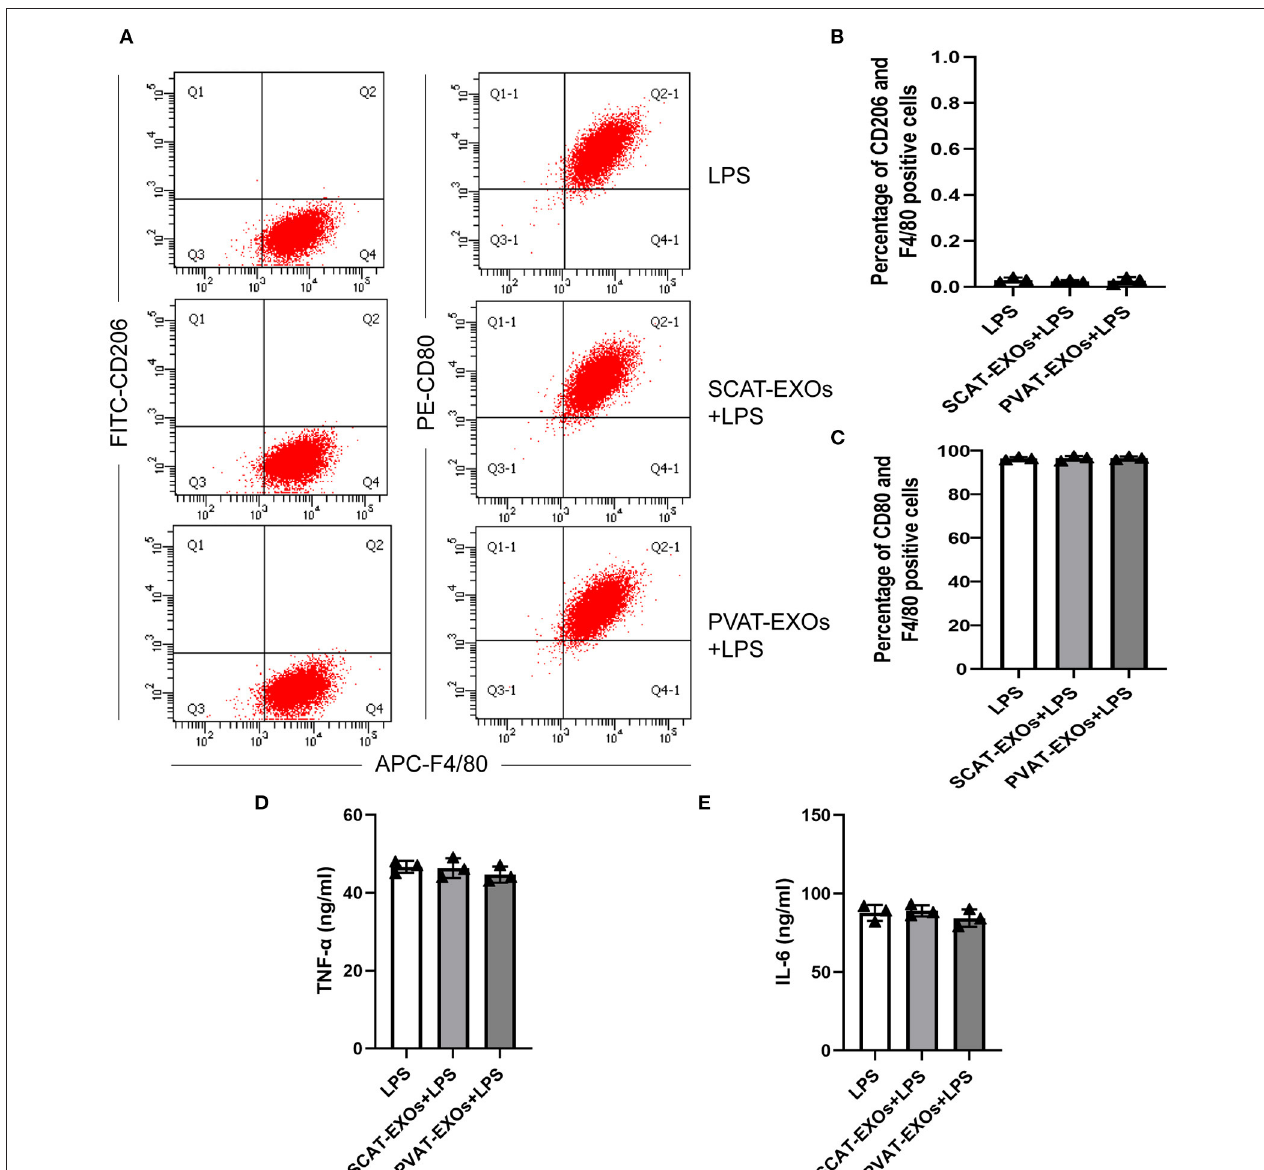
FIGURE 4 | Macrophage polarisation was not affected by SCAT-EXOs or PVAT-EXOs. RAW264.7 cells were incubated with SCAT-EXOs, PVAT-EXOs or equal amounts of PBS and then incubated with lipopolysaccharide (LPS). The phenotypes of cells were analysed by flow cytometry (A) . There was no significant difference in the percentages of CD206 + /F4/80 + cells or CD80 + /F4/80 + cells between the groups (B,C) . The production of TNF-a (D) or IL-6 (E) was not affected by